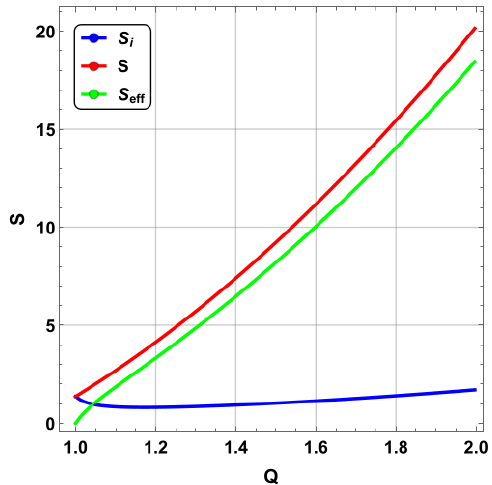
Figure 21. Black hole entropy as a function of electric charge when an extremal black hole gets charged absorbing 10 3 particle with a fixed charge dQ = 0 . 001 . The initial conditions are Q = 1 , l = 1 , M = 1 . 23 , r h = r i = 0 . 65 and D = 4